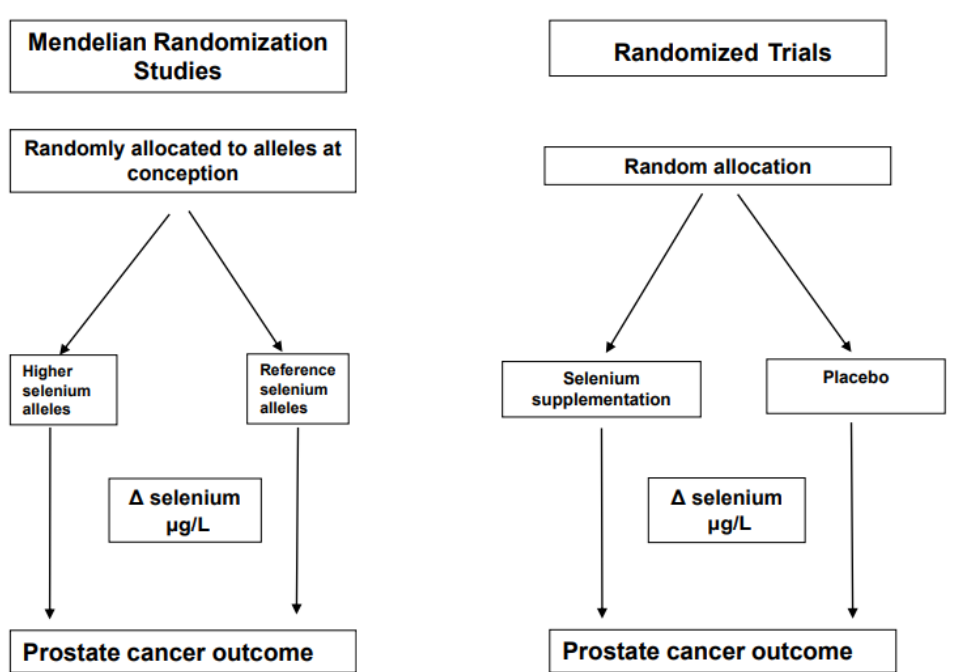
Figure 2. Comparison of a conventional trial with a Mendelian Randomization study. This illustrates the analogy between a conventional randomized controlled trial and a Mendelian randomization study. ∆ represents the change.